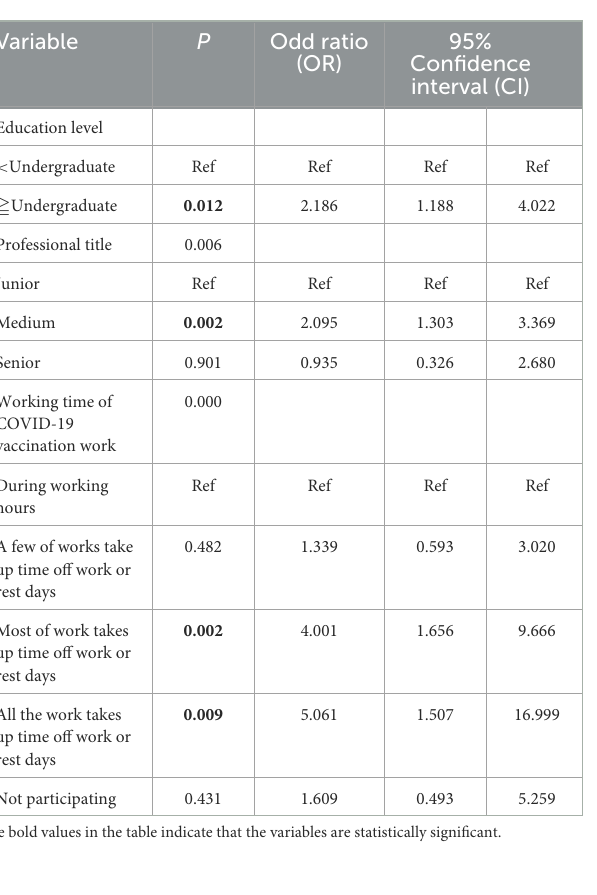
TABLE 3 Binary logistic regression results of burnout among vaccination staff.